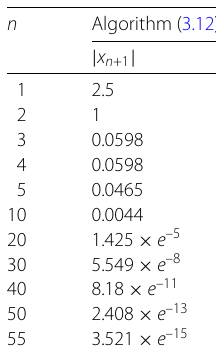
Table 3 Table of values choosing x 0 = 1, x 1 = 2.5